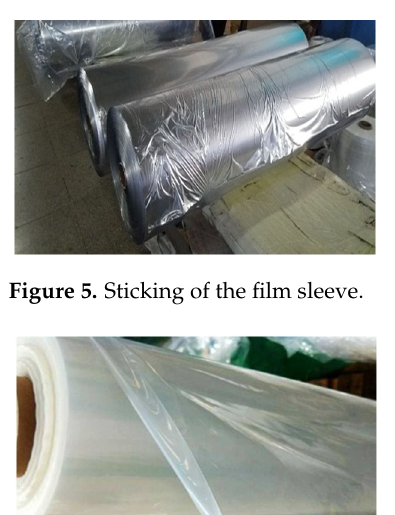
Figure 4. Matte canvas surface on sleeve.